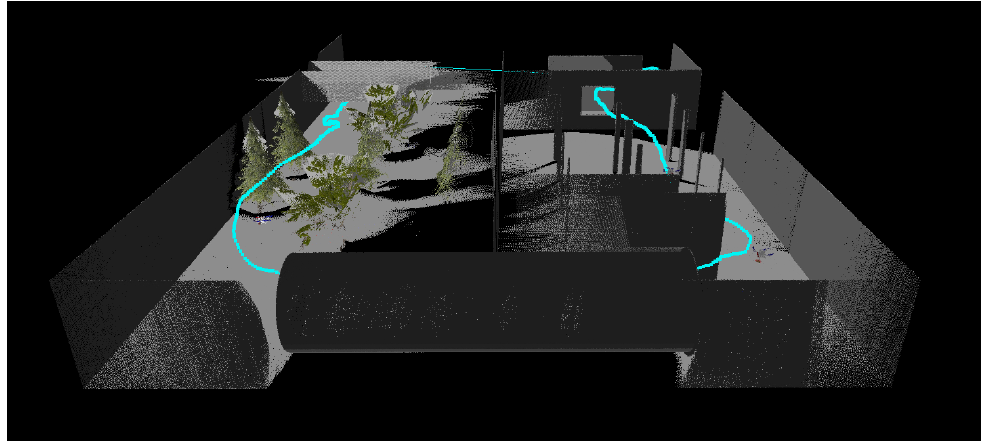
Figure 25. Visualization of the trajectory of UAV controlled by the SCAN algorithm (Area 1, Area 2, and Area 3), side-view.